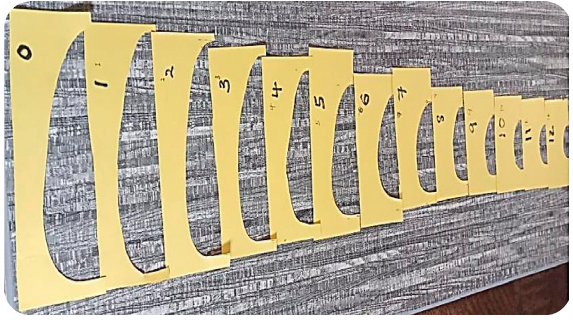
4: Styrofoam blades reinforced in fiber material.